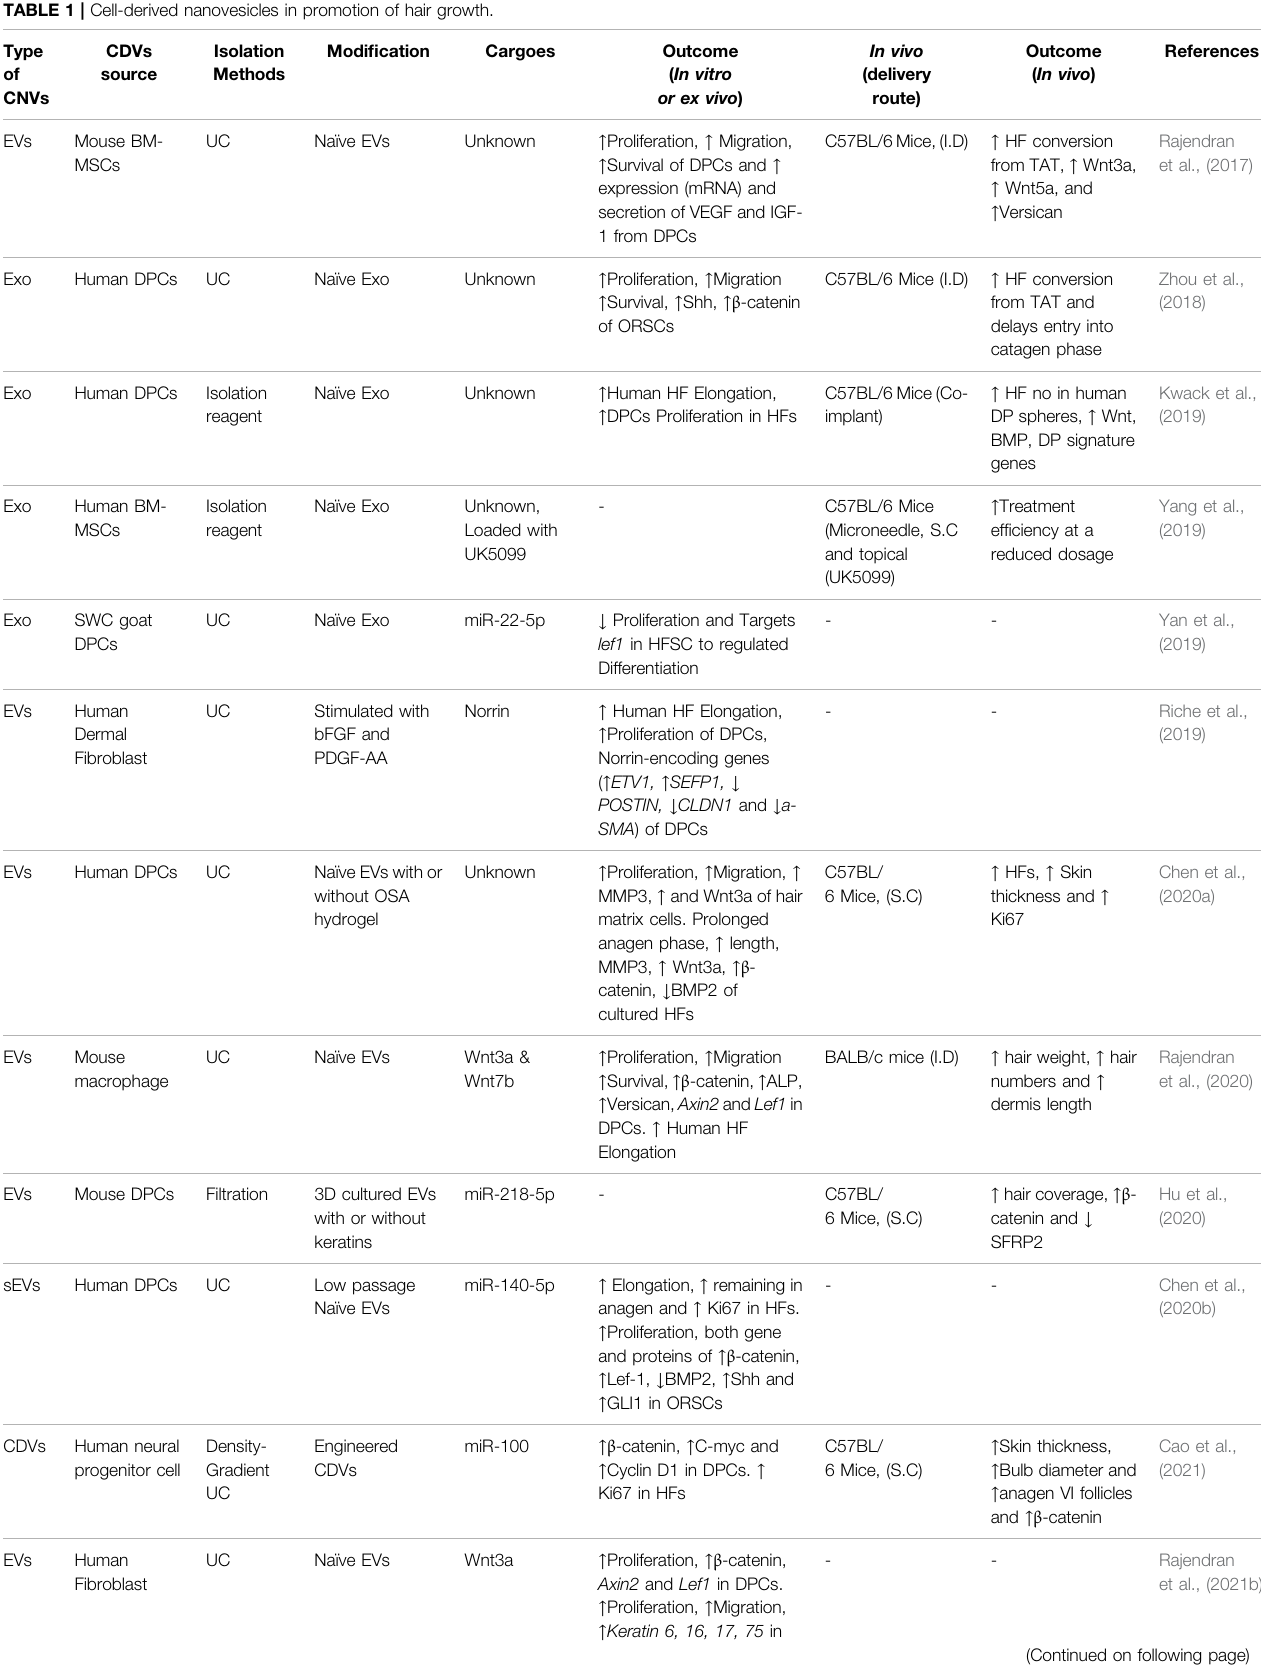
TABLE 1 | Cell-derived nanovesicles in promotion of hair